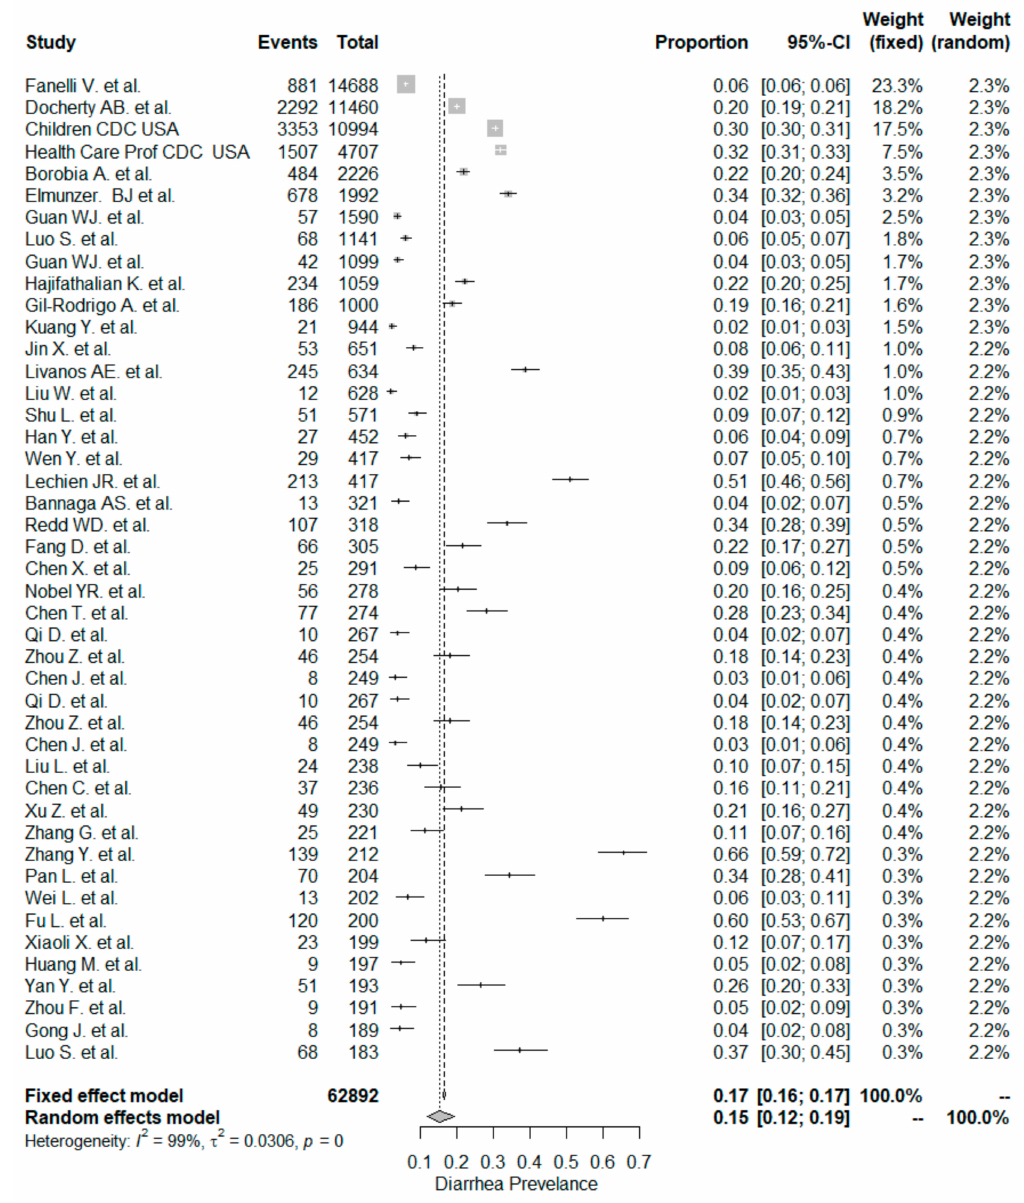
Figure 2. All studies, diarrhea forest plot and meta-analysis